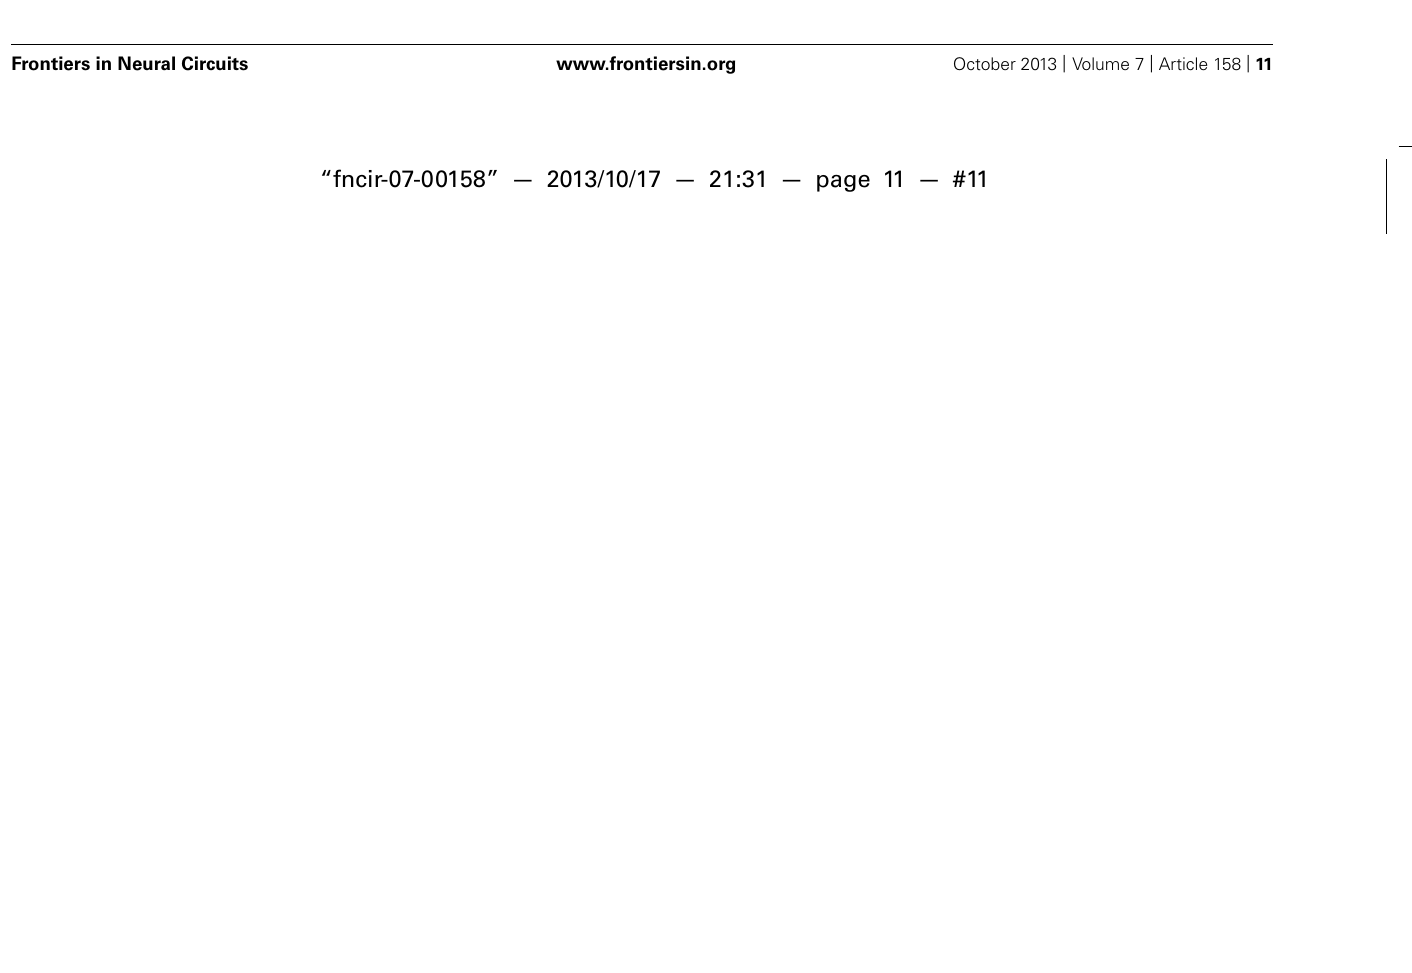
goals that were informed by the visual signals ( Figure 12B ),